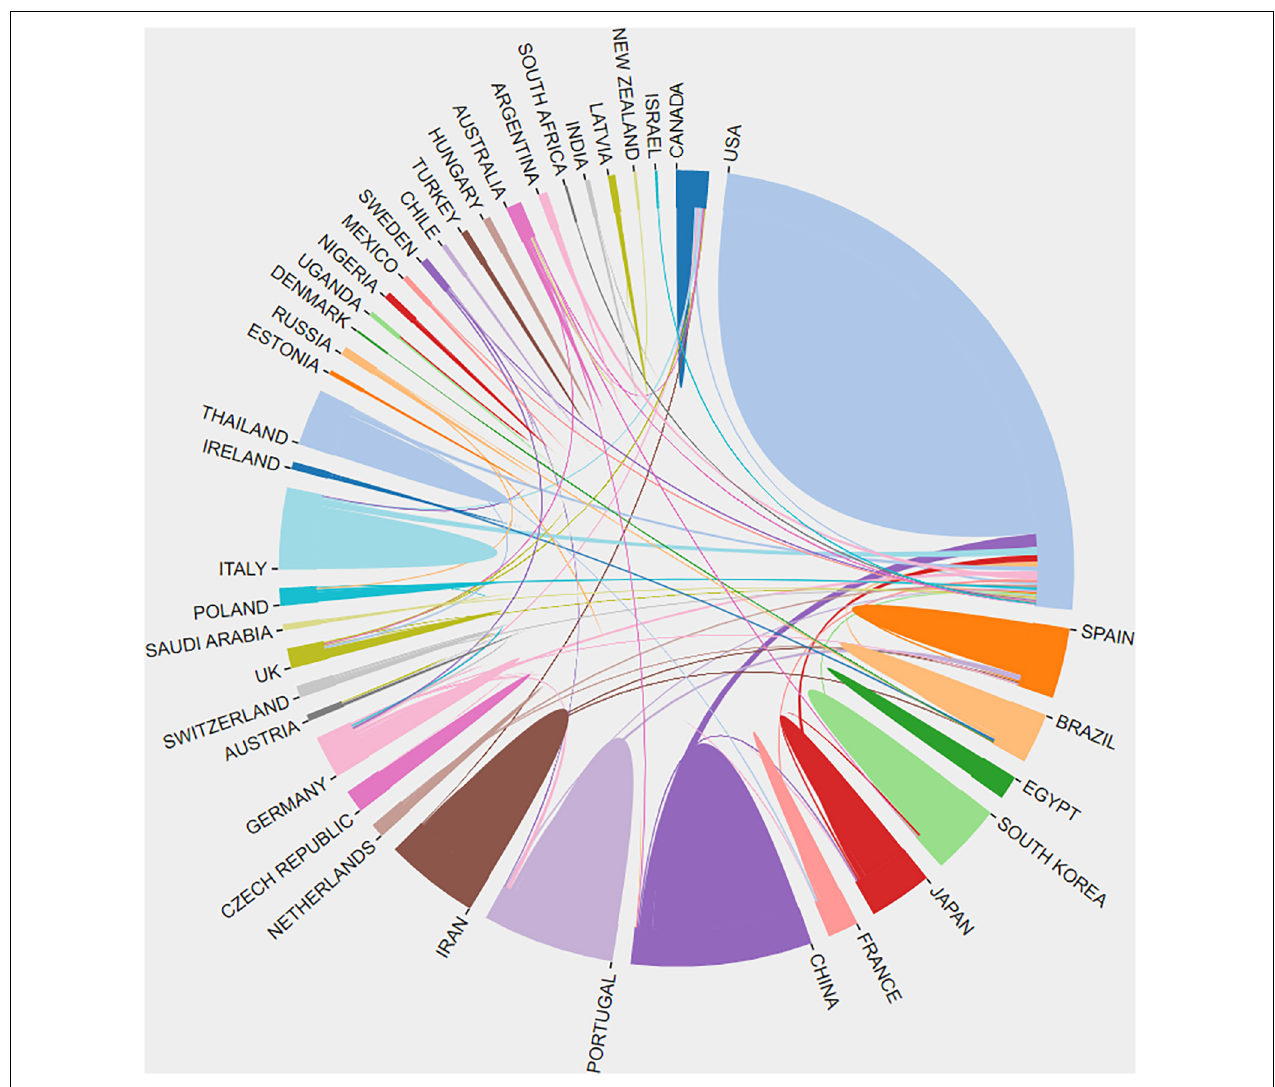
FIGURE 3 | Cooperation between contributed